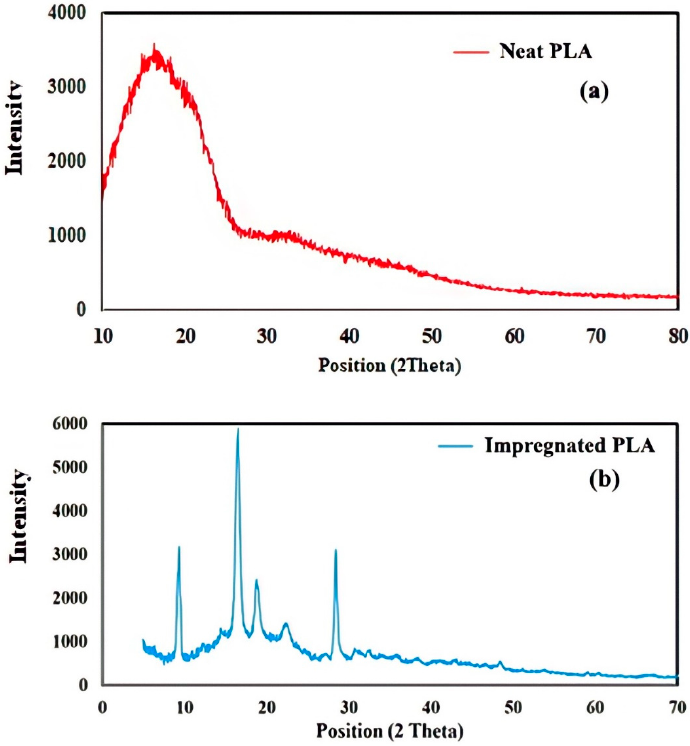
Figure 9. XRD patterns of ( a ) neat PLA and ( b ) PLA impregnated at the optimum